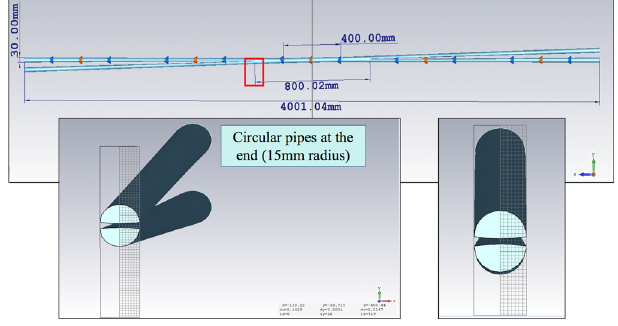
FIG. 5. Geometry of the IR model 1. The cross section near the pipe connection shows how the incoming pipes were squeezed to the half circle shape.